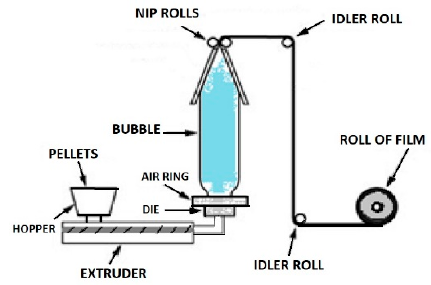
Figure 4. Schematic diagram of the blown film process [1].